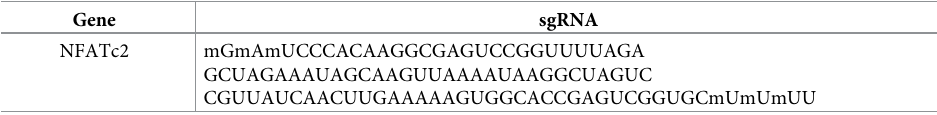
Table 5. The sgRNA used in this study.